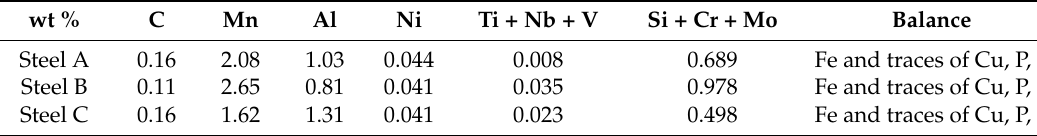
Table 1. Compositions of the experimental steel